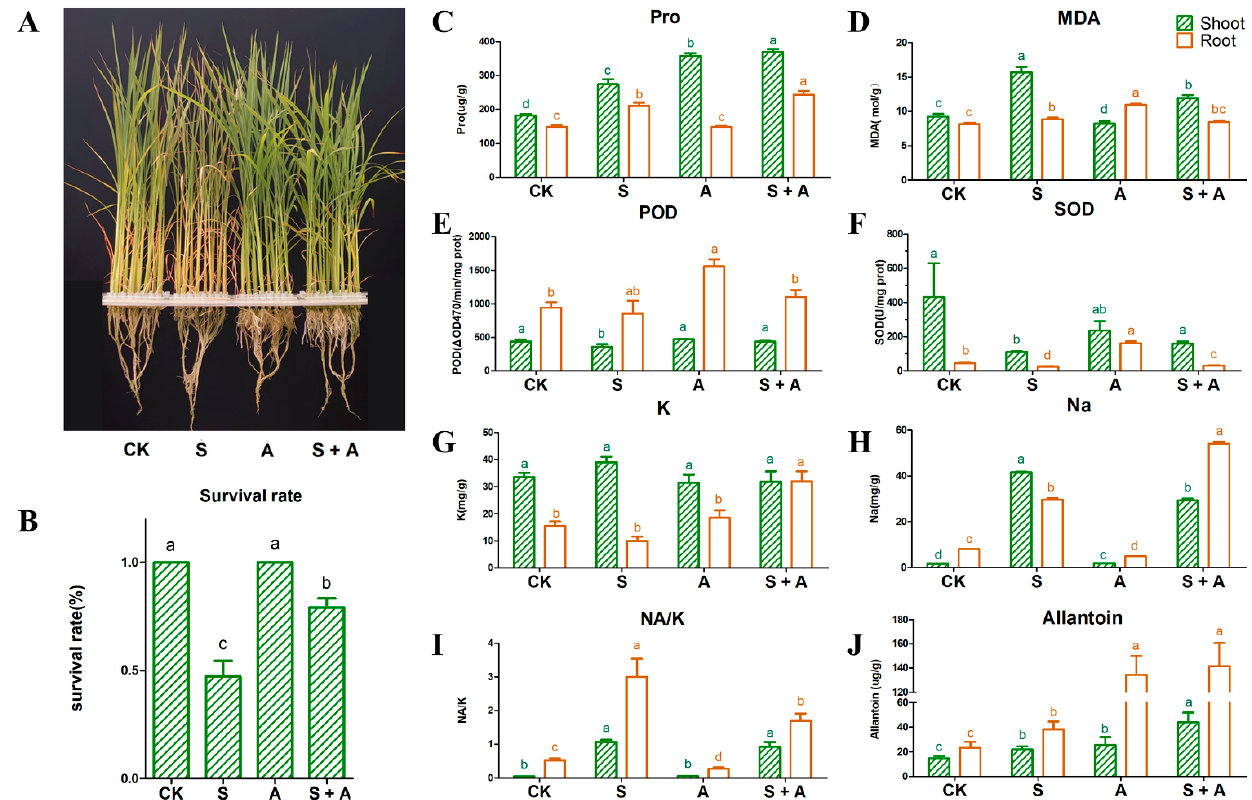
Figure 1. Phenotypic and physiological analyses of C18 seedlings under different treatment condi- tions. Phenotypes of the C18 seedlings in response to different treatments ( A ). Survival rates of C18 seedlings after a 14-day treatment and a 7-day recovery period ( B ). Proline ( C ), MDA ( D ), POD ( E ), SOD ( F ), K + ( G ), and Na + ( H ) contents and Na + /K + ratio ( I ) in the shoots and roots after different treatments. Allantoin contents in the shoots and roots after different treatments ( J ). The rice seedlings were maintained under control conditions (CK) or were treated with 140 mM NaCl (S), 10 mM allantoin (A), or 140 mM NaCl + 10 mM allantoin (S + A) for 7 days. Letters a,b,c, and d represent the results of significant difference analysis. The same letter marks indicate no significant difference between two groups of data, while different letters indicate a significant difference between two groups of data ( p < 0.05).